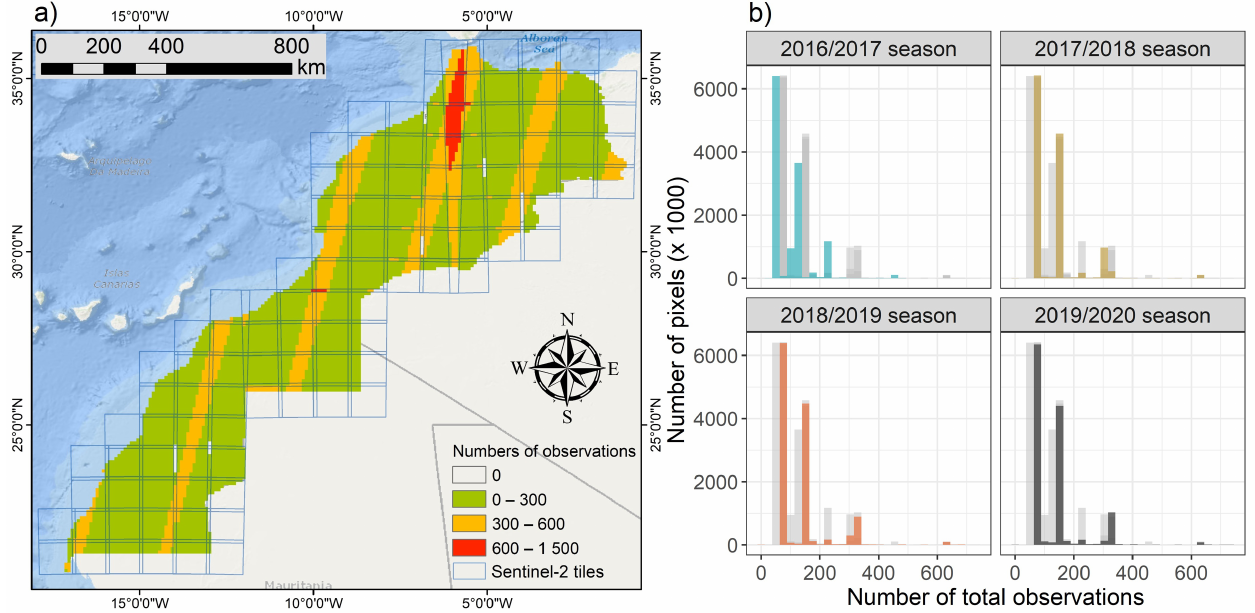
Figure 3. ( a ) Spatial distributions of the total Sentinel-2 images across the entirety of Morocco from 2016 to 2020 ( b ) The histograms of Sentinel-2 pixels of the total observations across the study area for each